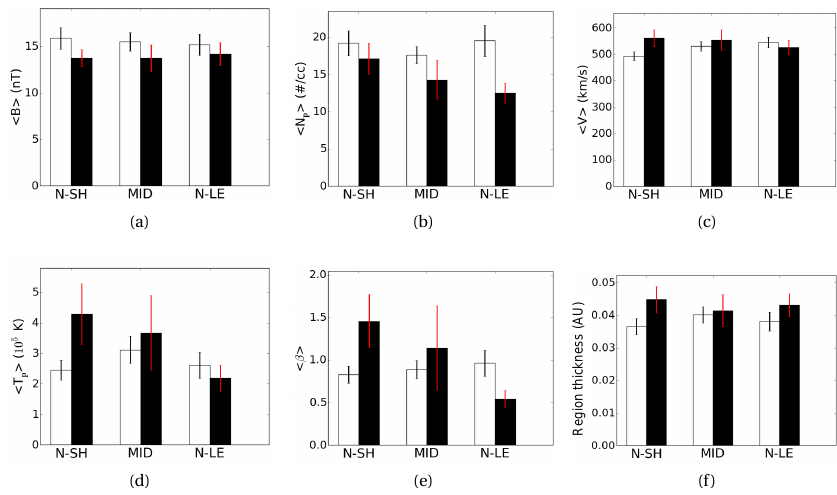
Figure 5. Dependence of PMS occurrence on average sheath plasma parameters in each sheath sub-regions (Near-Shock: N-SH, Mid-Sheath: MID and Near-LE: N-LE). The white bars represent the averages within the sub-regions where our PMS criteria were satisfied (67% PMS coverage), while the black bars show the averages in non-planar sub-regions (0% PMS coverage). The black and red error bars show the extent of one standard deviation. The studied parameters are the following: (a) magnetic field magnitude, (b) proton number density, (c) solar wind speed, (d) proton temperature, (e) plasma beta, and (f) sub-region